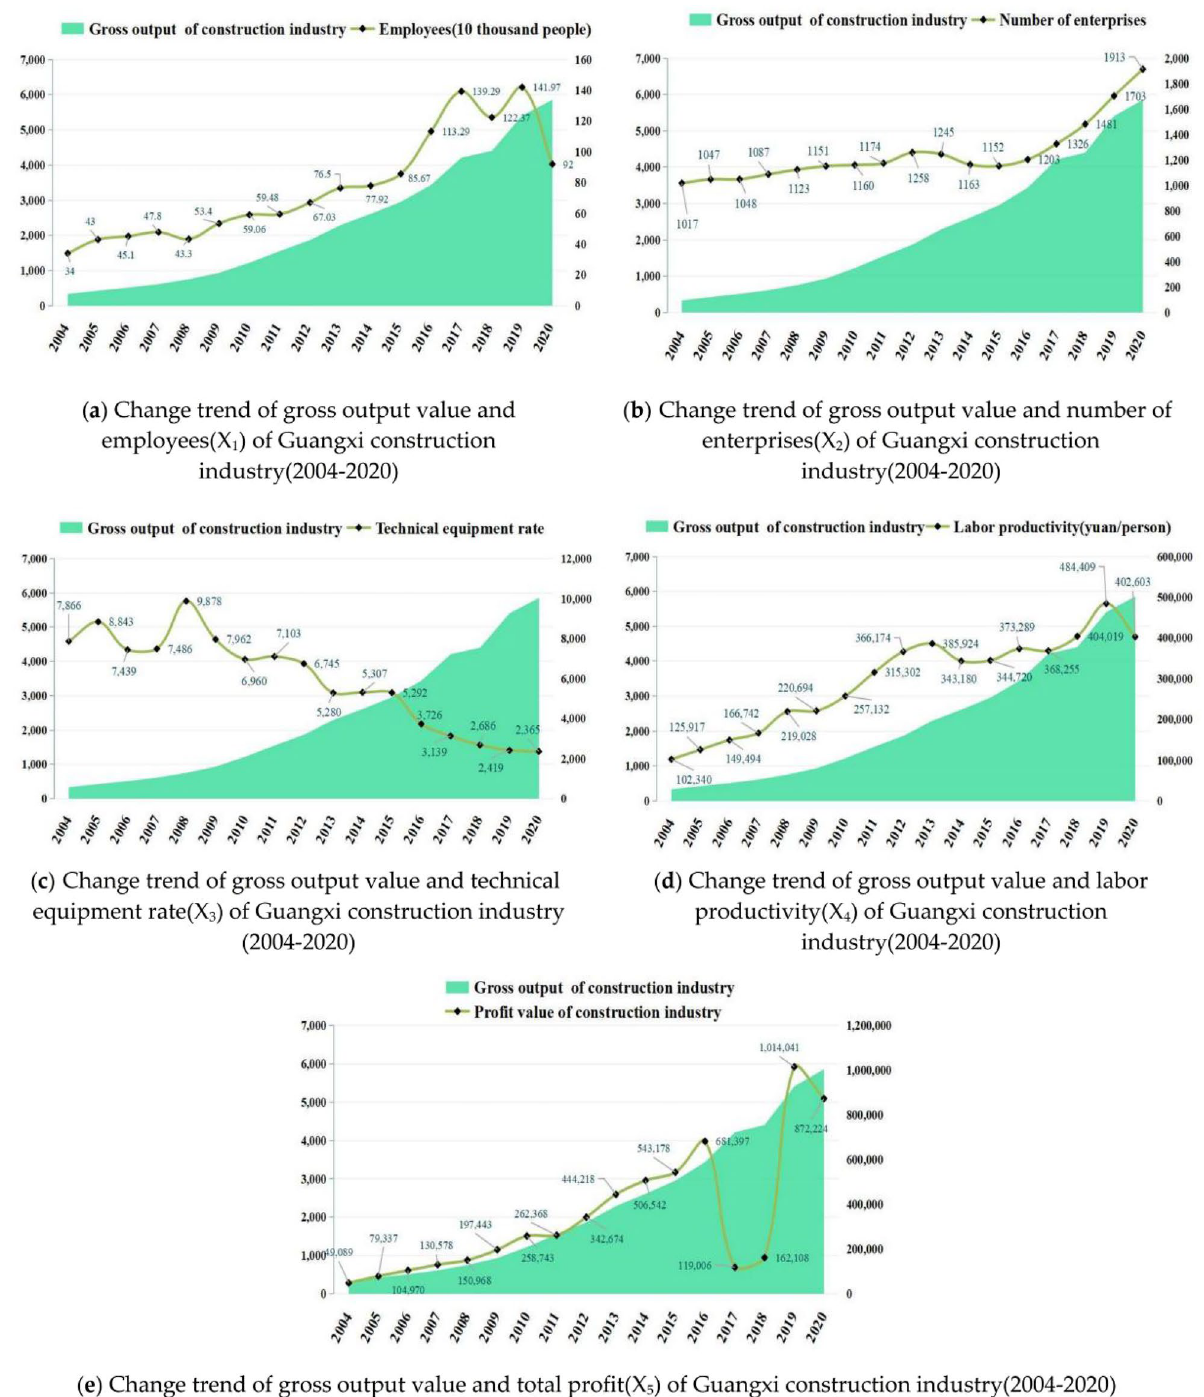
Figure 3. Change trend between gross output and another factors of of Guangxi construction industry from 2004 to 2020:( a ) Change trend of gross output value and employees(X 1 ) of Guangxi construction industry from 2004 to 2020;( b )Change trend of gross output value and number of enterprises(X 2 ) of Guangxi construction industry from 2004 to 2020;( c )Change trend of gross output value and technical equipment rate(X 3 ) of Guangxi construction industry from 2004 to 2020;( d )Change trend of gross output value and labor productivity(X 4 ) of Guangxi construction industry from 2004 to 2020;( e )Change trend of gross output value and total profit(X 5 ) of Guangxi construction industry from 2004 to